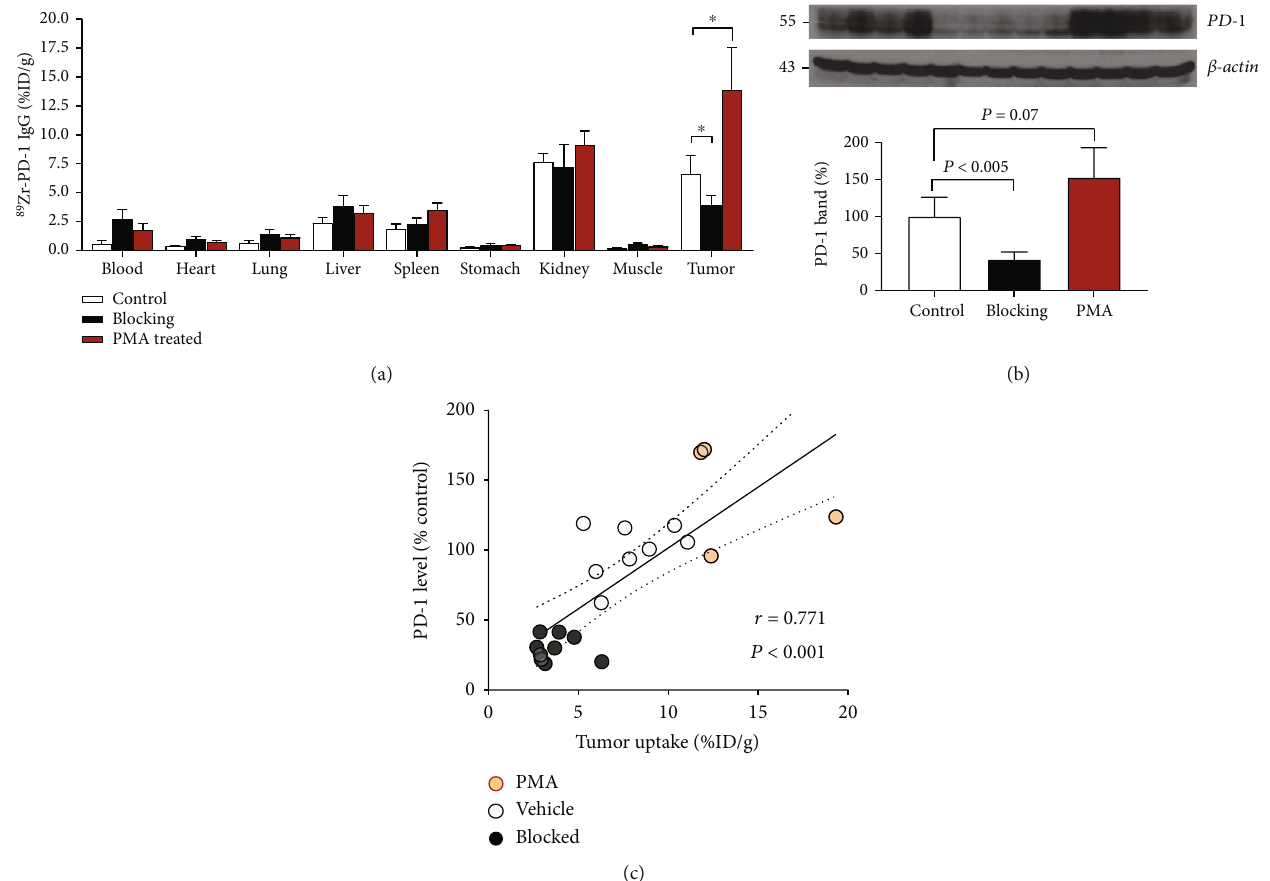
Figure 6: E ff ects of PMA on 89 Zr-PD-1 IgG biodistribution and tumor PD-1 expression. (a) 89 Zr-PD-1 IgG uptake in organs of EL4 tumor- bearing mice treated with vehicle (control) or PMA. The blocking group was conjected with excess cold anti-PD-1 antibody. (b) Immunoblots of tumor tissue from the above animals for PD-1 protein and band intensities corrected by β -actin. All bars represent the mean ± SD of quadruple mice per group. ∗ P < 0 : 05 and † P < 0 : 005 . (c) Correlation between tumor PD-1 content and tumor 89 Zr-PD-1 IgG uptake level. Data from two separate experiments include eight mice of the control group (empty circle), eight of the blocking group ( fi lled circle), and four of the PMA group (red circle). The solid line denotes the linear regression, and dotted lines indicate the 95% con fi dence